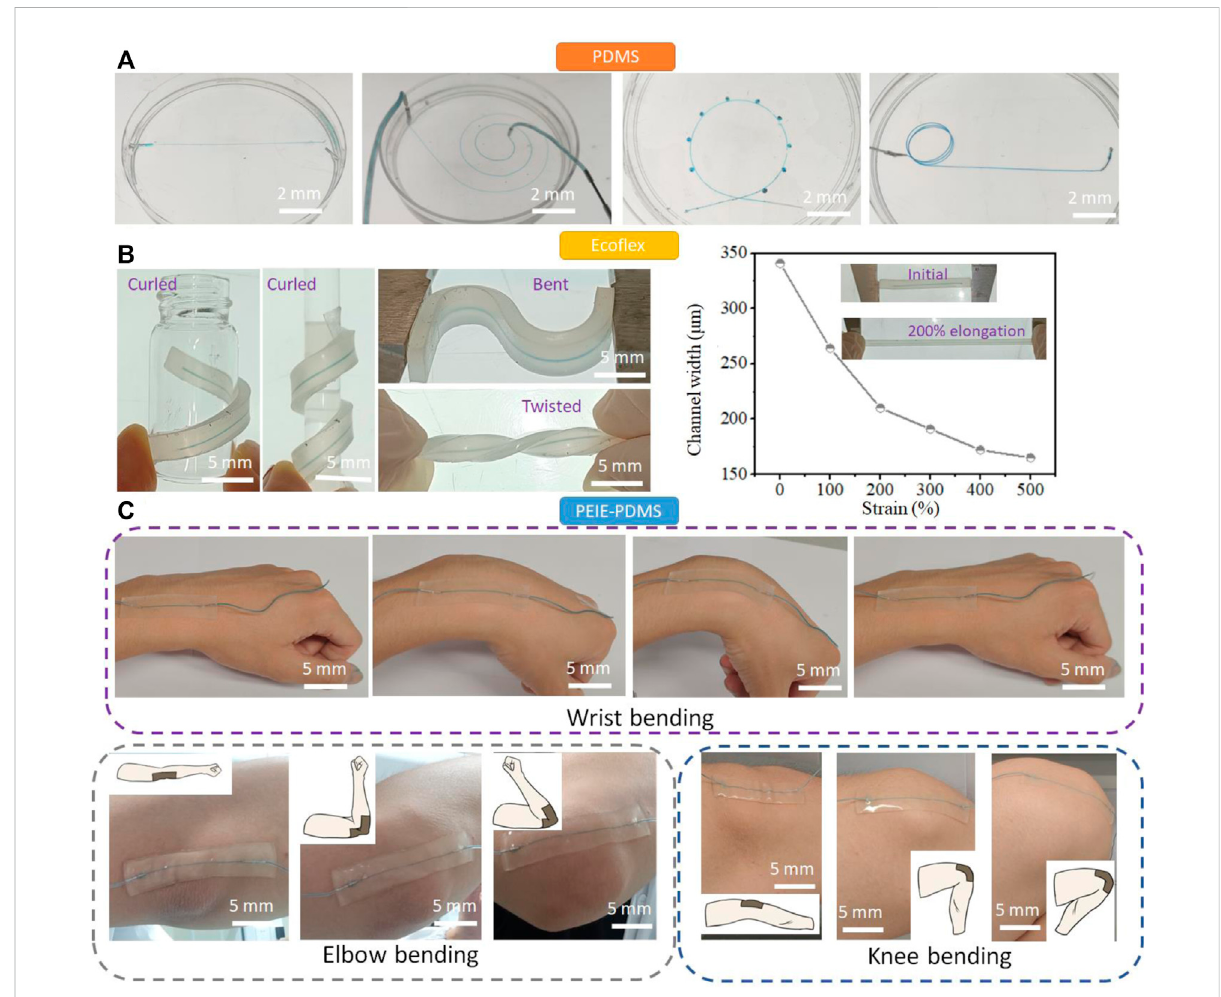
Creationofthemicro fl uidicchannels. (A) ThevariousPDMSmicrochannelincludingstraightchannel,spiralchannel, “ Ferriswheel ” channel,and 3D helical channel fabricated via the LM molds. (B) Soft, stretchable Eco fl ex microchannels fabricated using the LM molds. The Eco fl ex micro fl uidic chipscanbecurled,bent,twisted,andelongatedtomodulatethestructureandsizeofthemicrochannel. (C) Thesoft,stickyPEIE-PDMSmicro fl uidic chip fabricated using theLM molds. The prepared PEIE-PDMS microchip can have a conformal contact with human joints such as wrist, elbow, and